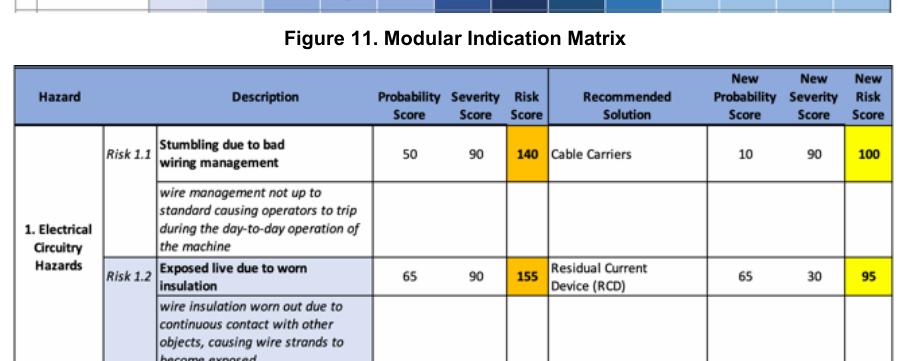
Figure 11. Modular Indication Matrix